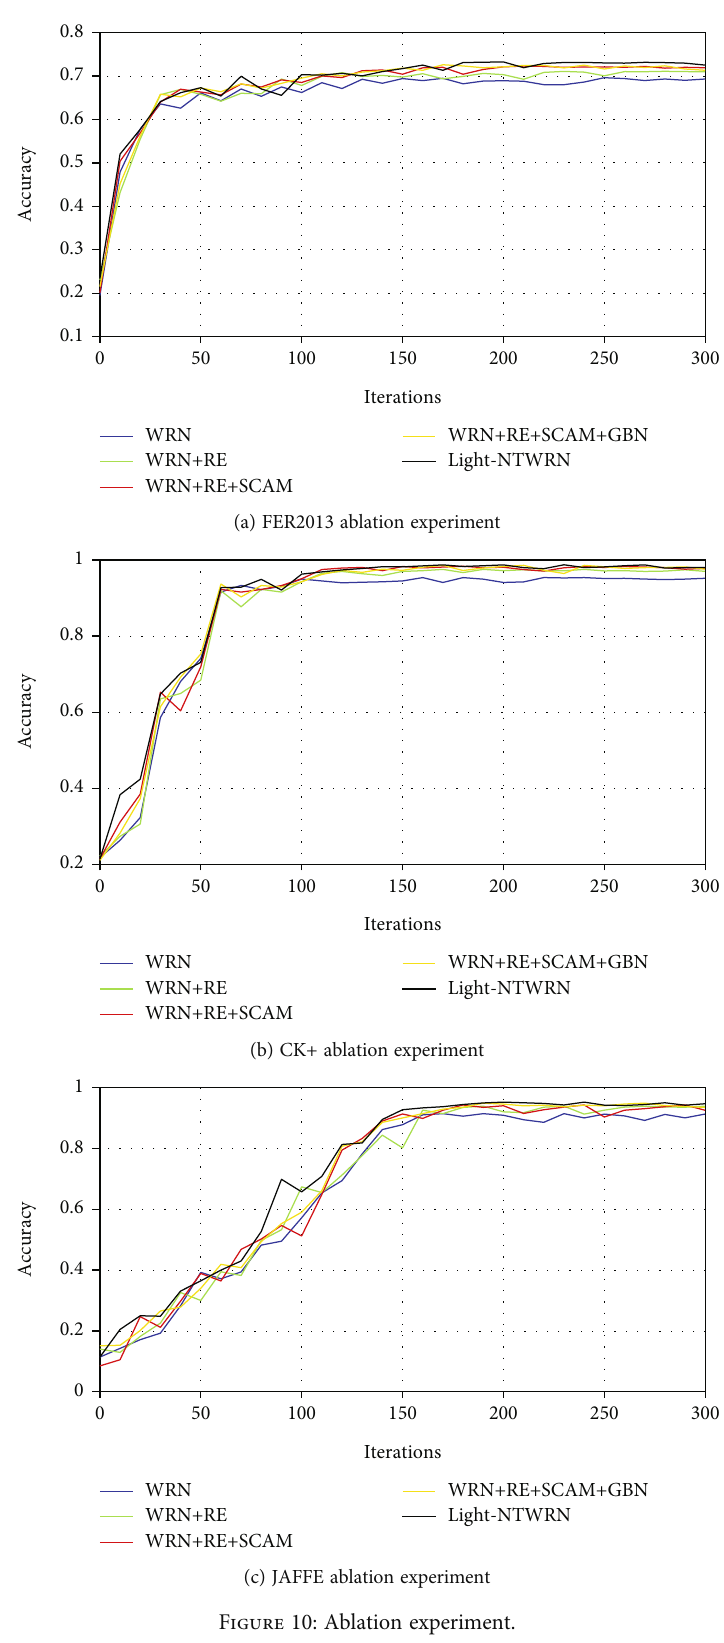
Figure 10: Ablation